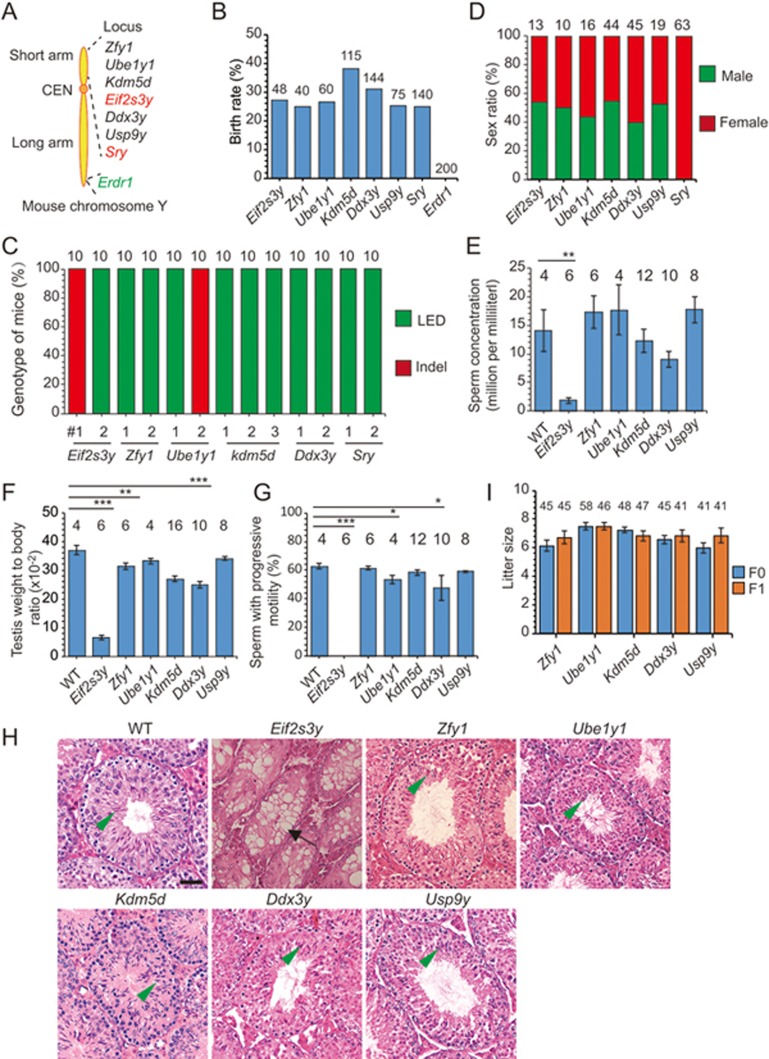
Phenotype analysis of F0 mice with individual Y chromosome gene deletion by C-CRISPR. (A) Schematic diagram of eight targeted genes in Y chromosome. Two sgRNAs were designed to target each gene. Red, gene previously studied with conventional knockout mice; green, gene located in both X and Y chromosomes. (B) Birth rate of mice with embryos edited by the C-CRISPR method for deletion of individual Y-chromosome gene. Number, total embryos transferred. Erdr1 targeting resulted in embryonic lethality. (C) Sex ratio of mice with deletion of different Y-chromosome genes. (D) DNA sequence analysis of gene-edited mice in Y chromosome by C-CRISPR. Tails of mice resulting from different gene targeting in Y chromosome were genotyped. LED, large-fragment exon deletion; Indels, insertion, or deletion of bases. Number above each column, total TA clones sequenced. (E-G) Sperm concentration (E) weight-to-body ratio of testis (F) and percentages of sperm with progressive motility (G) for mice with deletion of different Y-chromosome genes. Number, total number of samples counted (***P < 0.001, **P < 0.01, *P < 0.05, χ2 test). (H) Histological analysis of the testis sections from adult mice with deletion of different Y-chromosome genes. Arrow, abnormal vacuoles of seminiferous tubule; arrowhead, sperm. Abnormality was found only in the Eif2s3y deleted testis. Bar, 20 μm. (I) Reproductivity of F0 and F1 mice with deletion of different Y-chromosome genes. Number, total pups obtained.